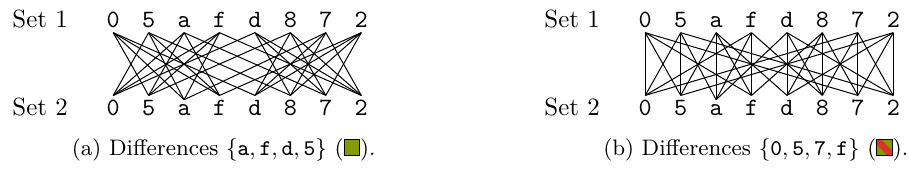
Figure 6: Initial structure with 8 · 4 pairs from 2 · 8 queries per